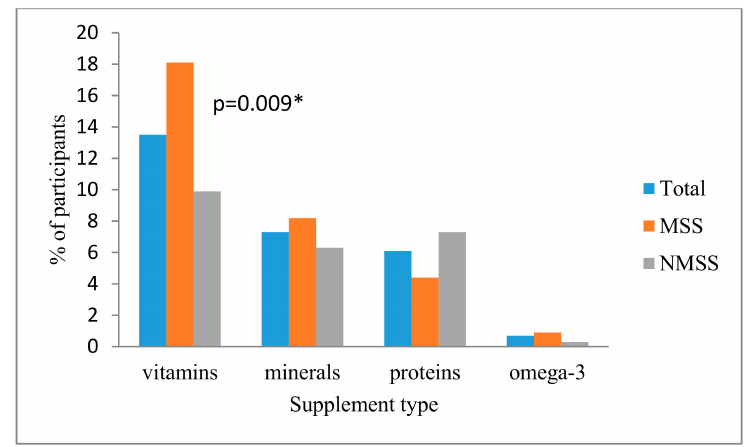
Figure 1. Types of dietary supplements consumed among the study participants ( N = 910). Medical sciences students (MSS); Non- medical sciences students (NMSS).